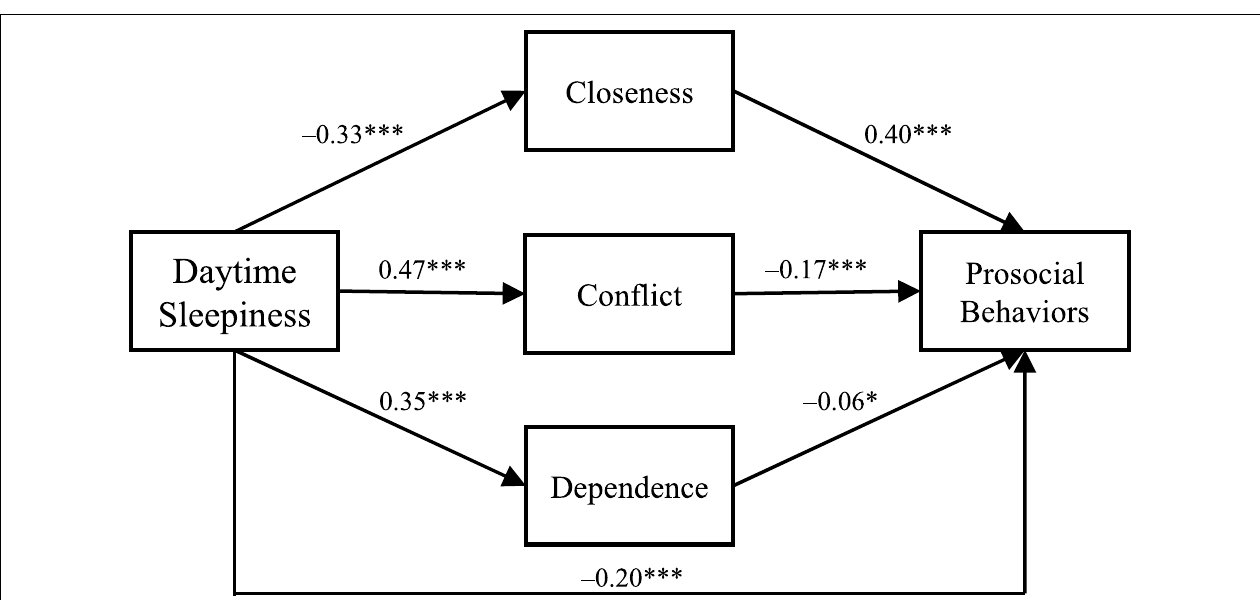
FIGURE 2 | The mediating role of student-teacher relationship between daytime sleepiness and prosocial behaviors. Children’s gender was included as control variables, but not presented for simplicity. ∗ p < 0.05, ∗∗∗ p <